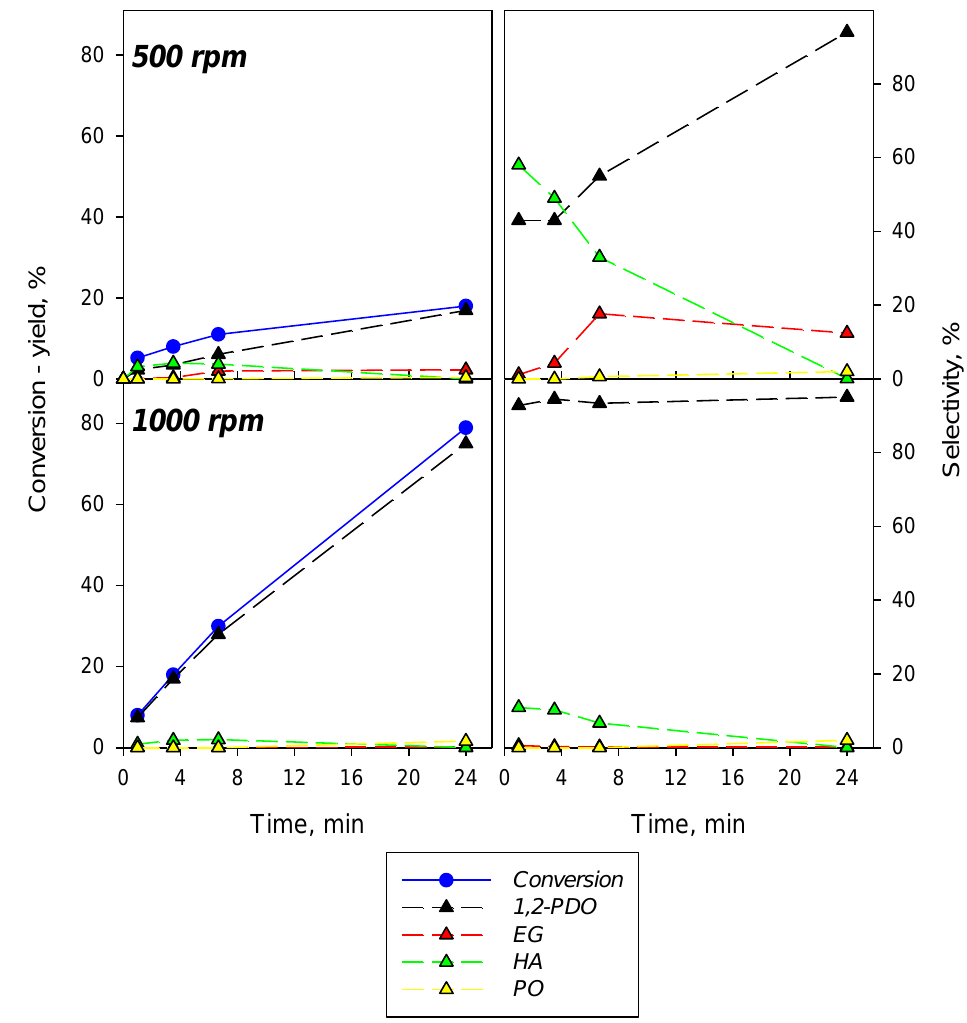
Figure 10. Cu(M)-Zr(C) glycerol conversion, yields, and selectivities to products as a function of the reaction time at different rotation speeds. Initial P = 20 bar(g); H 2 = 100 vol%; T = 240 °C (PDO = 1,2 propanediol, EG = ethylene glycol, HA = hydroxyacetone, PO = 1-propanol).